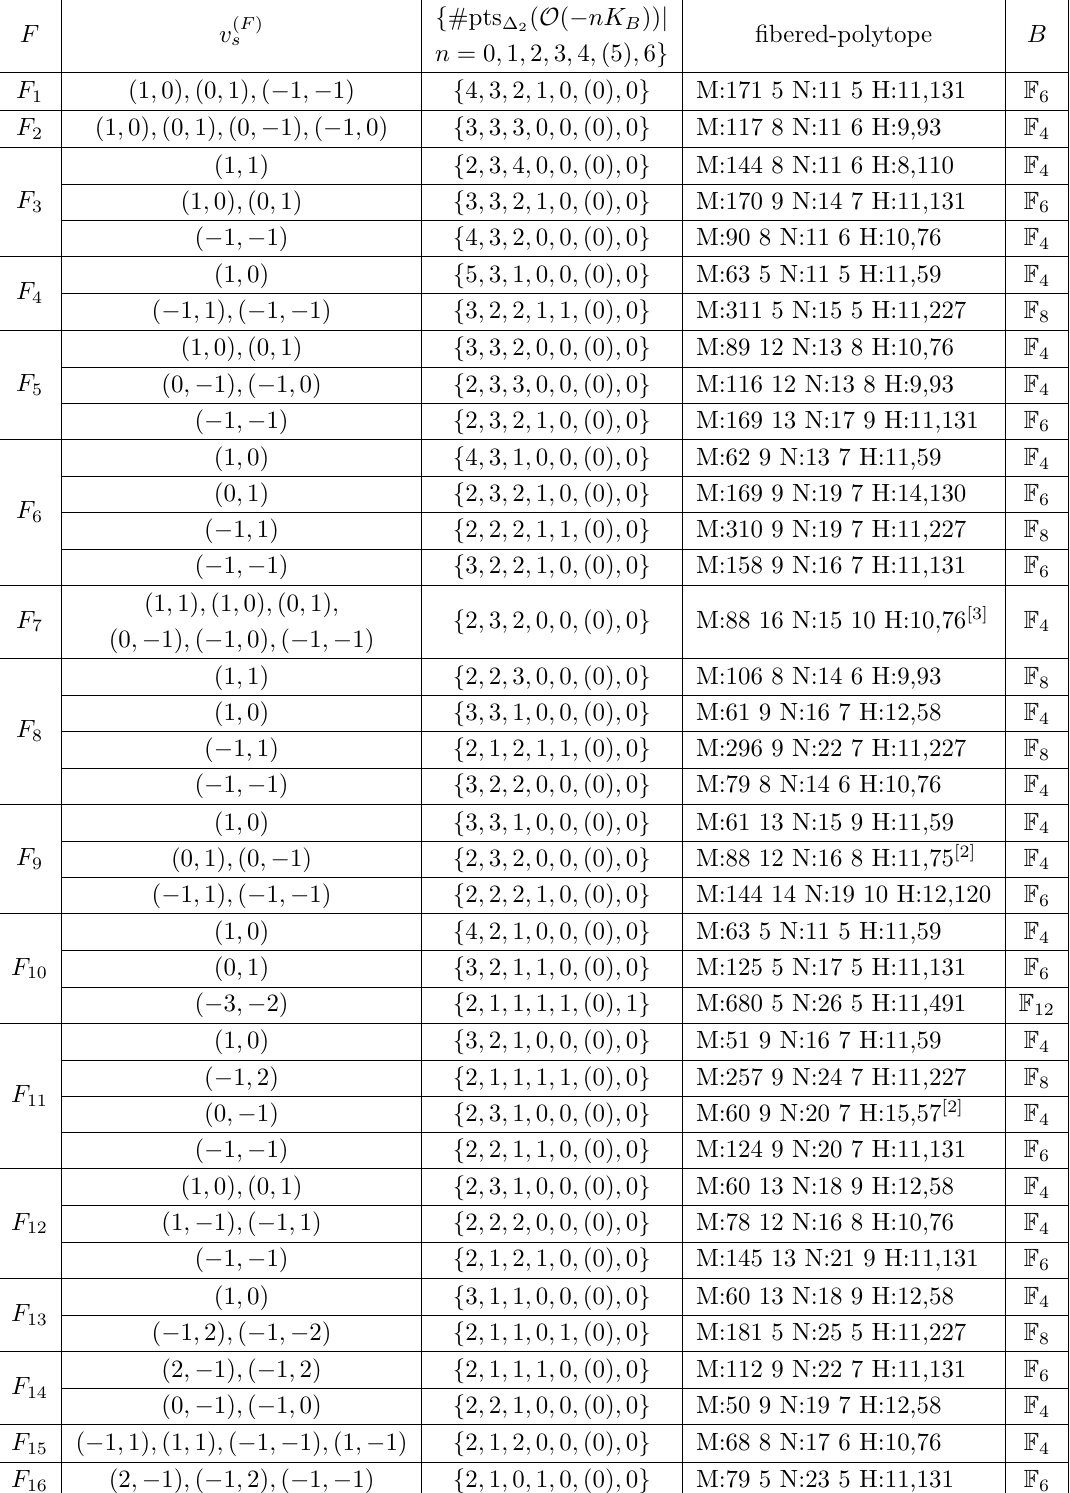
Table 8 . Line bundles in the v s stacking F -(cid:12)bered construction, with examples over Hirzebruch surfaces F m , where (cid:0) m saturates the negative curve bound in each case.